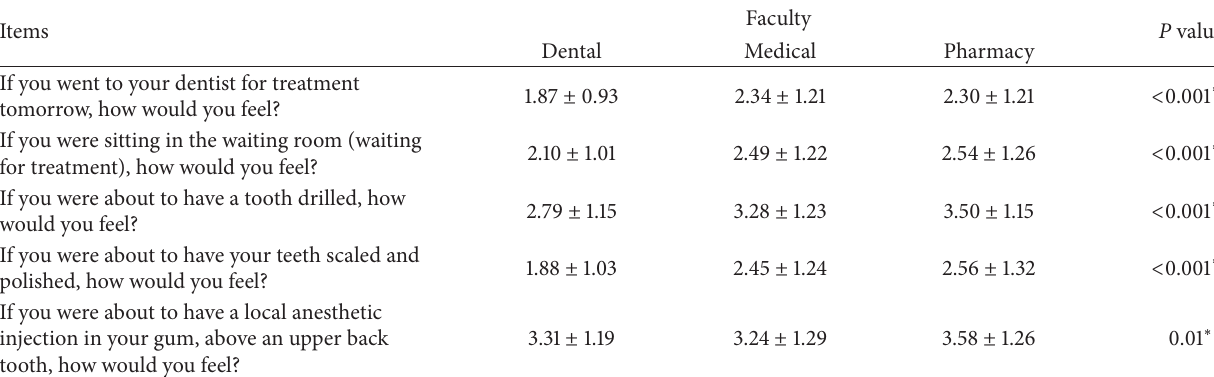
Table 5: Comparison of mean MDAS for each item according to field of